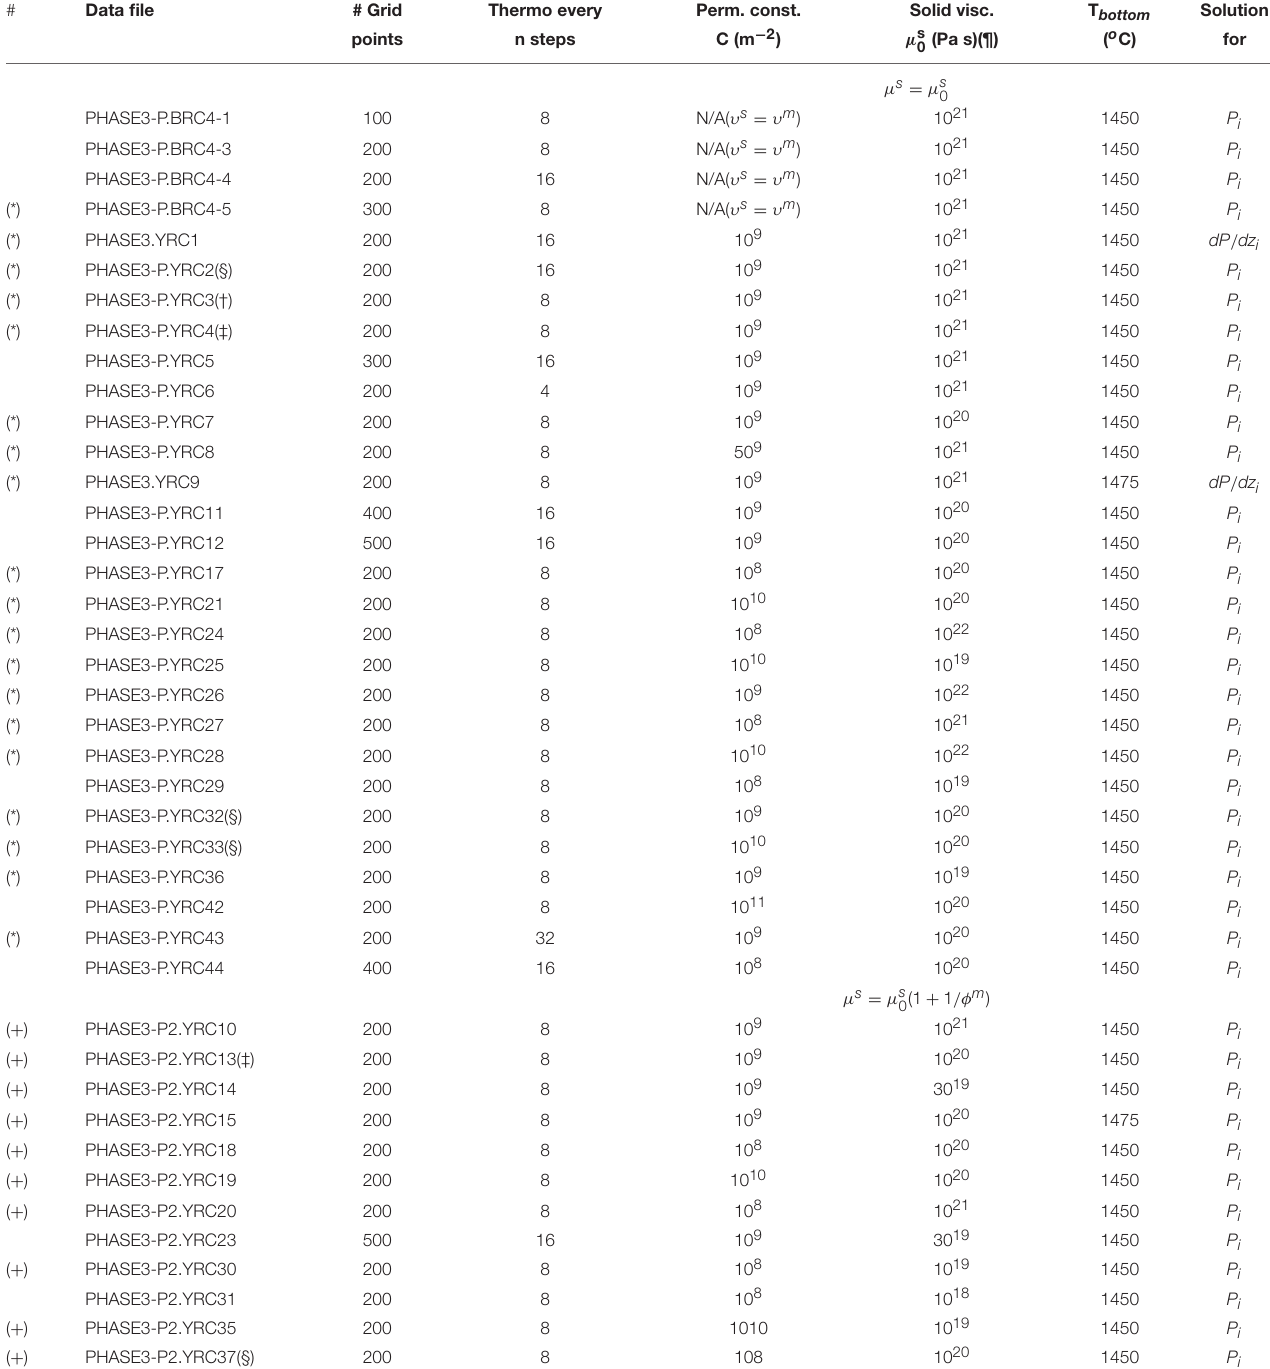
TABLE 1 | List of the dynamic melting simulations with thermodynamic